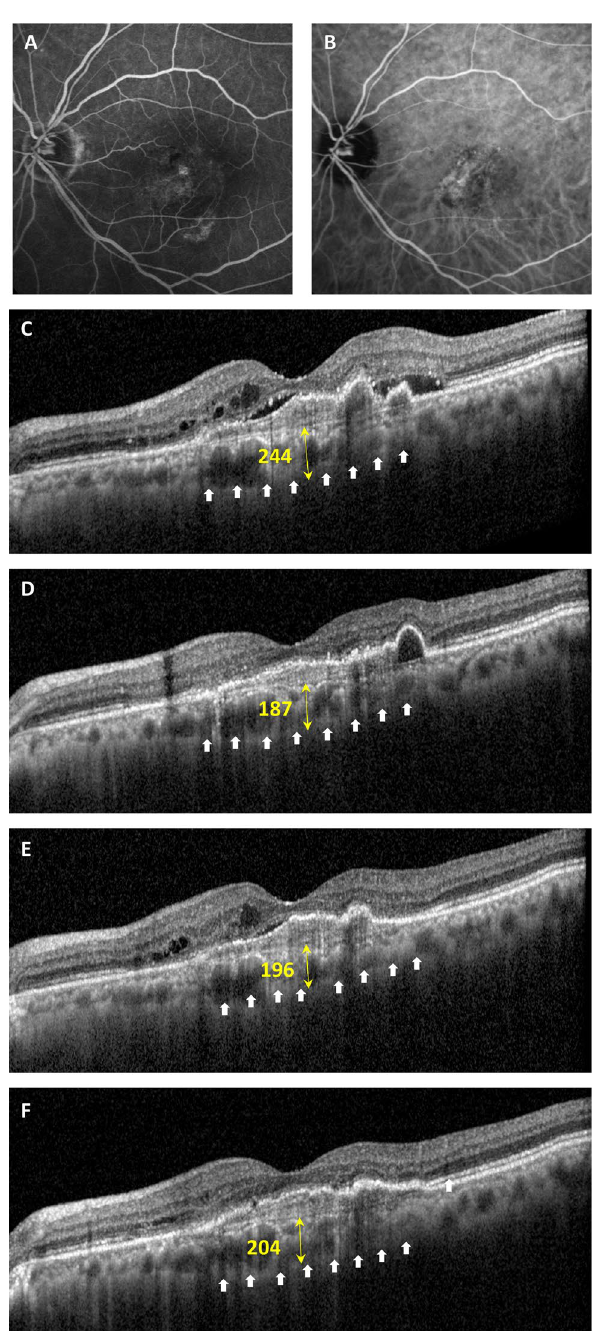
Figure 4. A representative case of a 69 year old male with polypoidal choroidal vasculopathy. The patient had previously received more than 10 treatments with ranibizumab and aflibercept, however macular exudation was persistent and treatment agent was switched to brolucizumab. ( A ) Fluorescein angiography and ( B ) indocyanine green angiography showing a subfoveal polyp with a branching vascular network. ( C ) Optical coherence tomography (OCT) at baseline showing fibrovascular retinal pigment epithelium detachment accompanied with intra and subretinal fluid. The white arrows indicate the inner scleral border and yellow arrows demonstrate the subfoveal choroidal thickness (SFCT). Central foveal thickness (CFT) was 333 μm and SFCT was 244 μm. ( D ) One month after the first brolucizumab treatment, CFT and SFCT were decreased to 253 and 187 μm, respectively. Complete fluid resolution was presented in the OCT image. Best corrected visual acuity (BCVA) also improved from 0.5 to 0.2 logarithm of the minimal angle of resolution (logMAR). No adverse reactions related with brolucizumab injection were reported. ( E ) Three months after first injection, intra and subretinal fluid was found in OCT scans and an additional injection was performed. CFT and SFCT were 317 and 196 μm and both were still reduced compared to baseline. ( F ) At last visit, six months after baseline, mild intraretinal fluid was remained and a third brolucizumab injection was administrated. BCVA was 0.15 logMAR. CFT and SFCT were 300 and 204 μm,